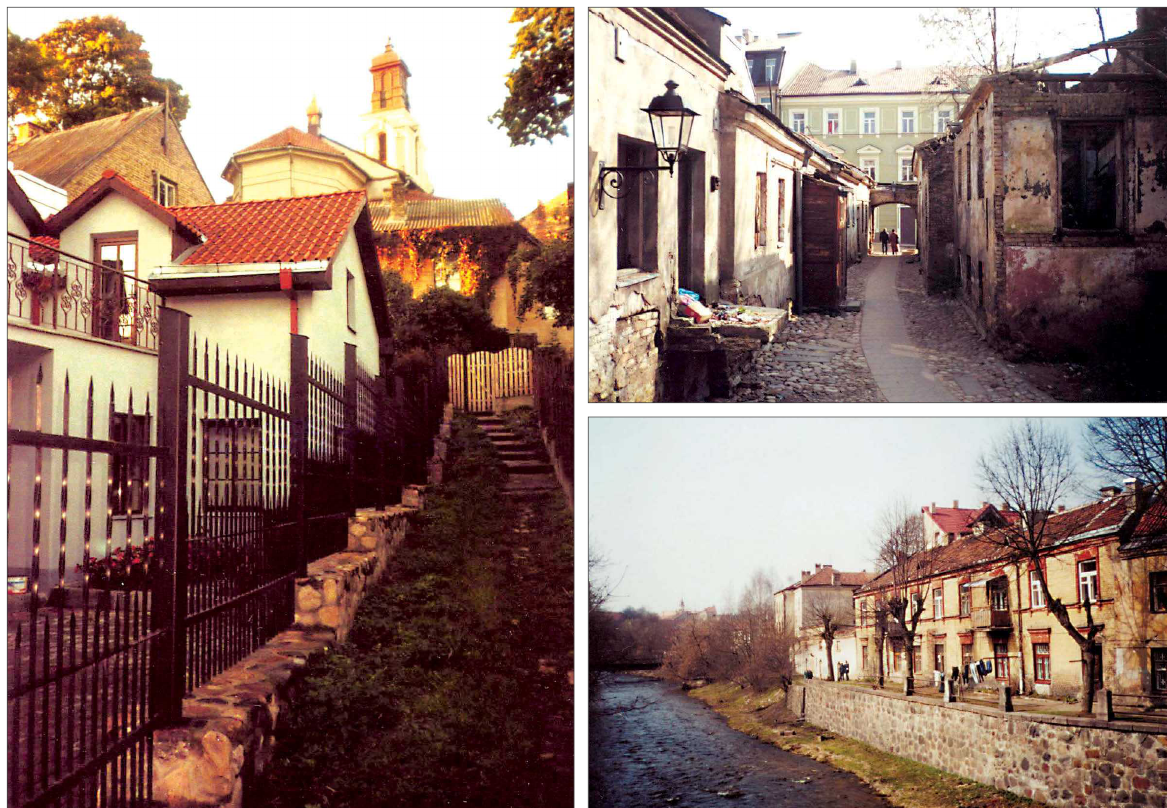
Fig 2. Contrasts of Užupis (author’s